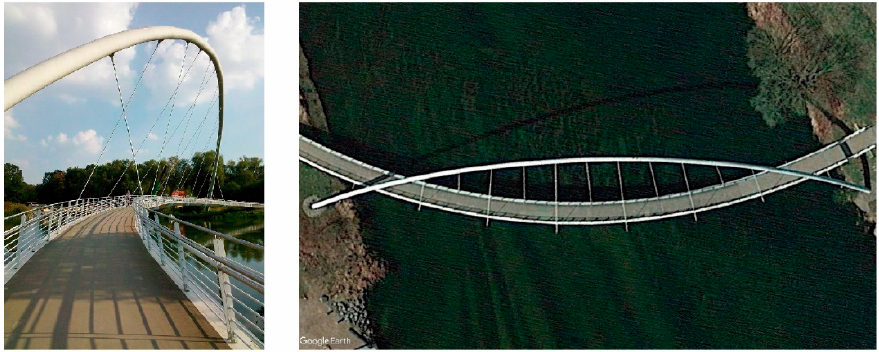
Figure 19. ( a ) Slodowa island Footbridge (photo, Metamorfa_Studio, pixabay.com), ( b ) Pont de l’Observatoire (photo, Le Cointois, Wikimedia Commons), and ( c ) Ripshorst Footbridge (photo: Nicolas Janberg, structurae.net).